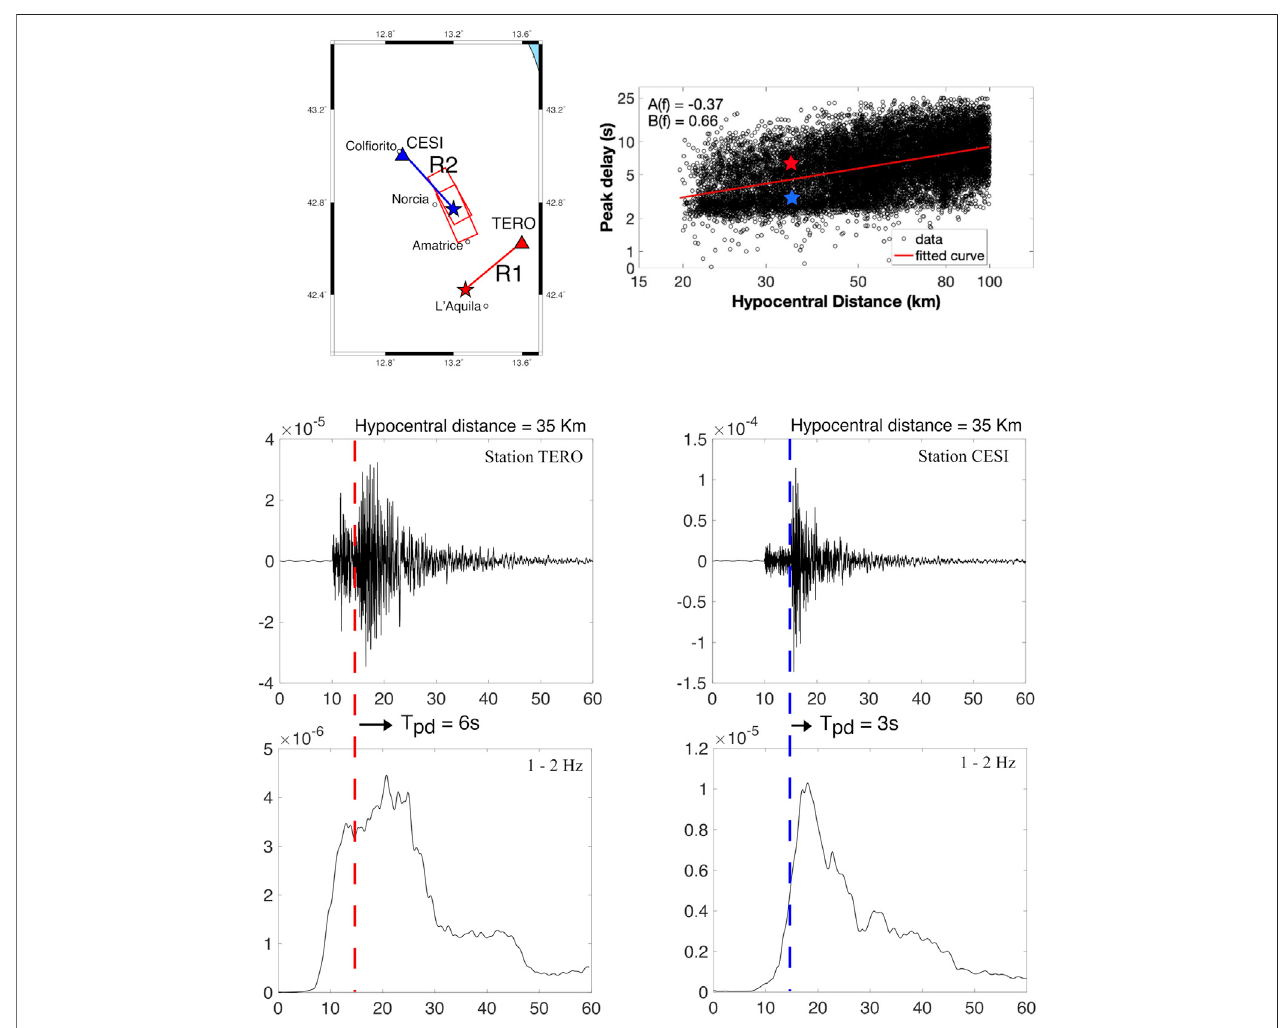
FIGURE 4 | Example of E-W component velocity seismograms recorded at CESI and TERO stations at the exact hypocentral distances, 35 km (top and middle panels),and theirsmoothing root-mean-squareenvelopes inthe1 – 2 Hz band(bottom panels). Theverticalblueand red dashed lines display theS-wave onset,and the horizontal black arrow expresses the peak delay